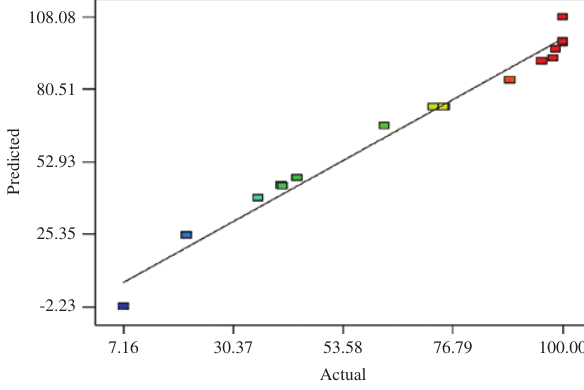
Figure 5: Interactive effects of drying temperature and material thickness on dehydration